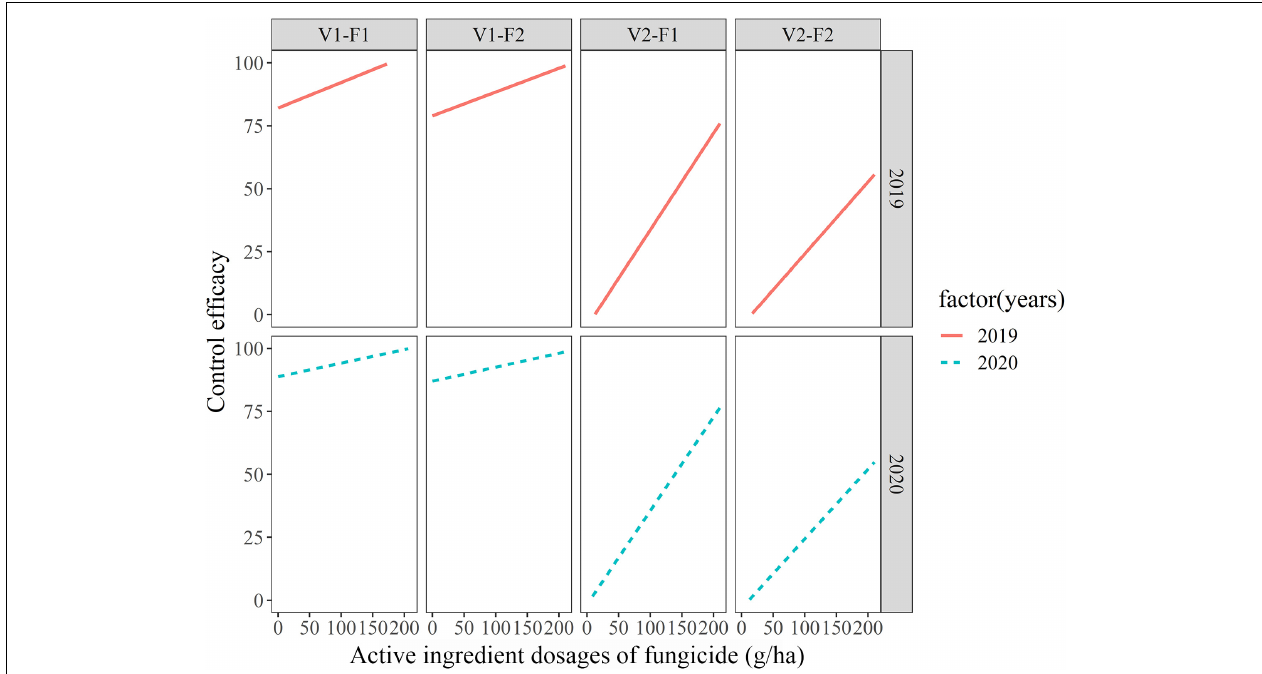
FIGURE 3 | Fitted random-coefficient models relating active ingredient dosages of fungicides to control efficacies on different variety-fungicide combinations among different years. F1 and F2 represent enostroburin · epoxiconazole 18% SC and triadimefon 20% EC, respectively; V1 and V2 represent highly resistant variety (“Baofeng104”) and highly susceptible variety (“Jingshuang16”), respectively.